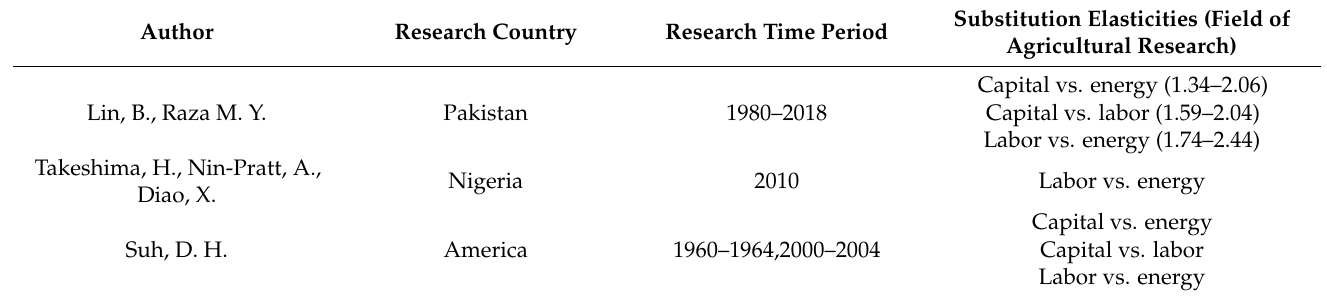
Table 7. Substitution relationships between different factors of production.